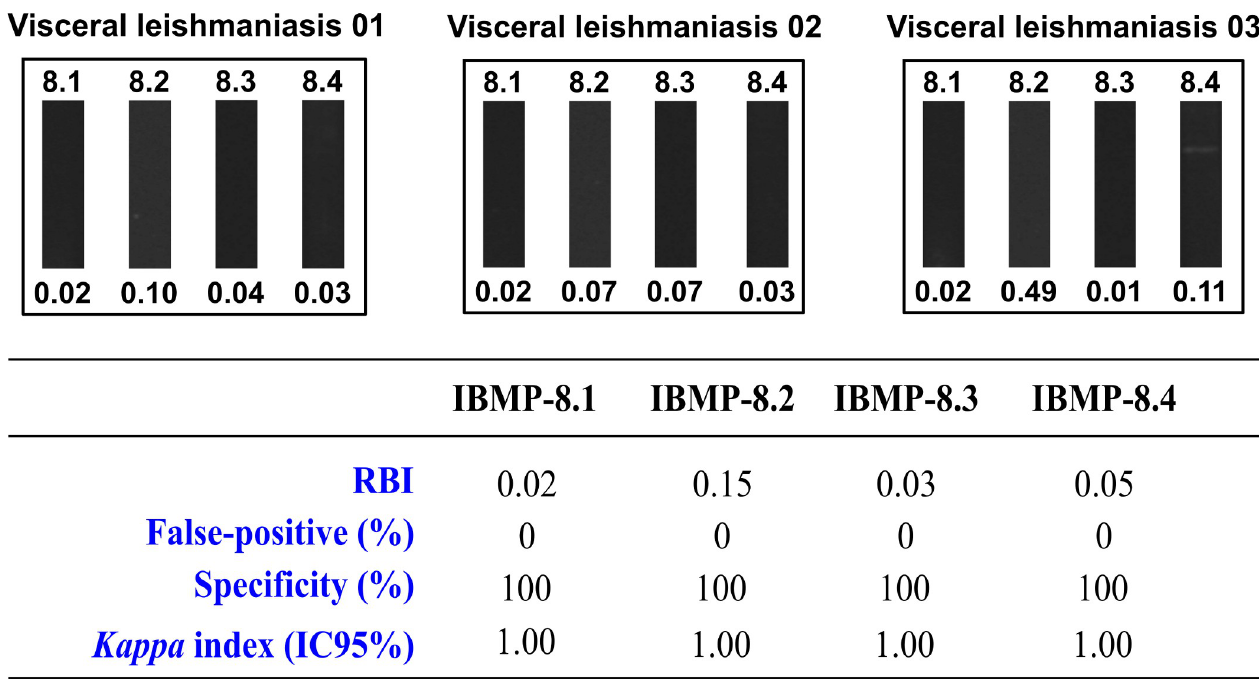
Fig 5. Analysis of cross-reactivity using chimeric Trypanosoma cruzi proteins to diagnose sera from visceral leishmaniasis patients. Relative band intensity (RBI) values for each sample are shown below the images.